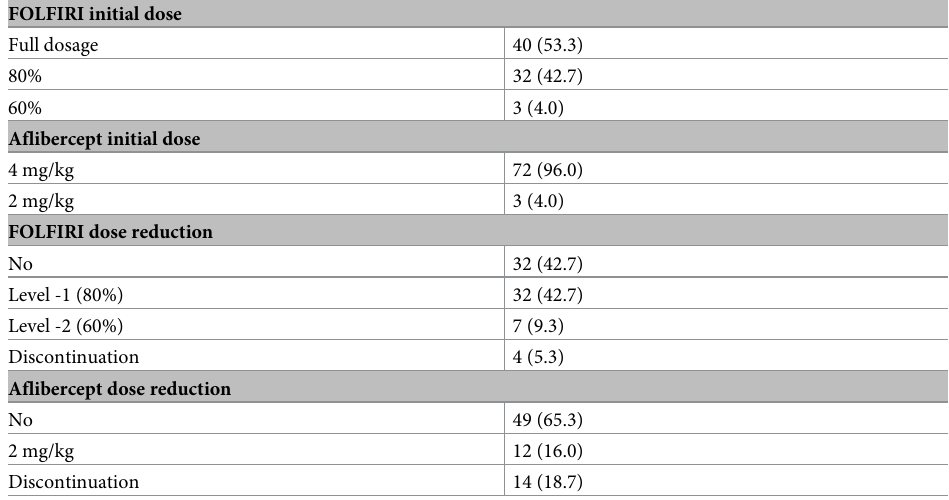
Table 4. Dose reduction and discontinuation during FOLFIRI aflibercept